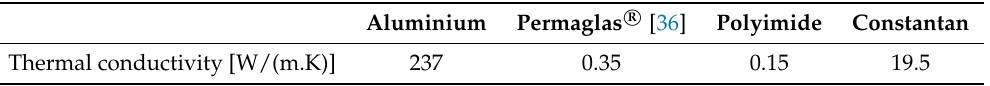
Table 4. Thermal conductivity for the materials that are used in our simulations.